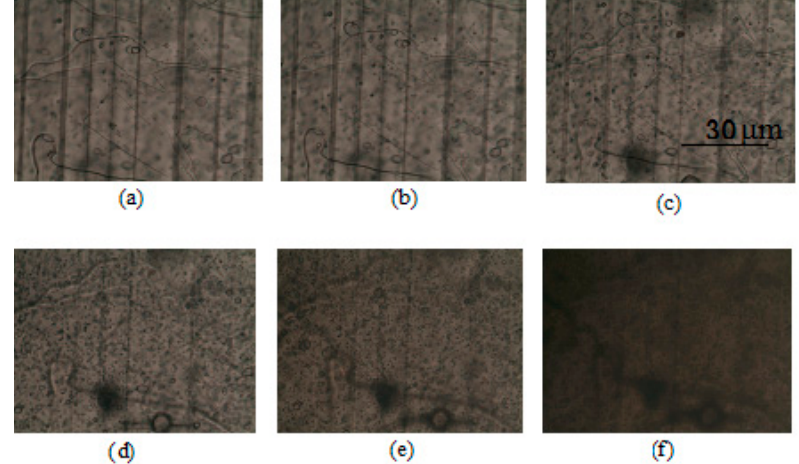
Figure 8. Optical polarizing microscopy images of (C 3 H 7 NH 3 ) 2 CdCl 4 single crystals at ( a ) 300 K, ( b ) 350 K, ( c ) 400 K, ( d ) 450 K, ( e ) 480 K, and ( f ) 500 K. The ferroelastic domain walls are represented as parallel lines.